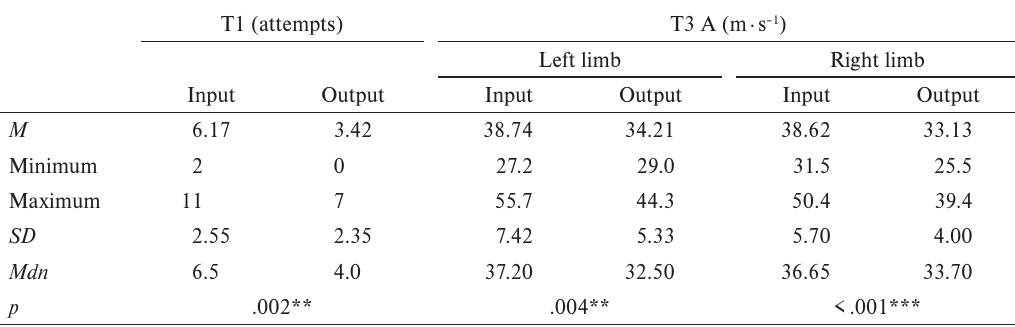
Static balance in experimental